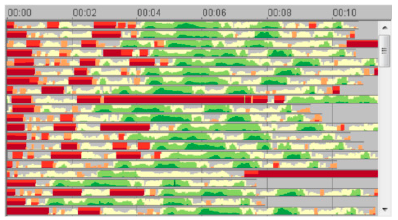
Figure 21. Time-series visualization of vehicle speed [38].